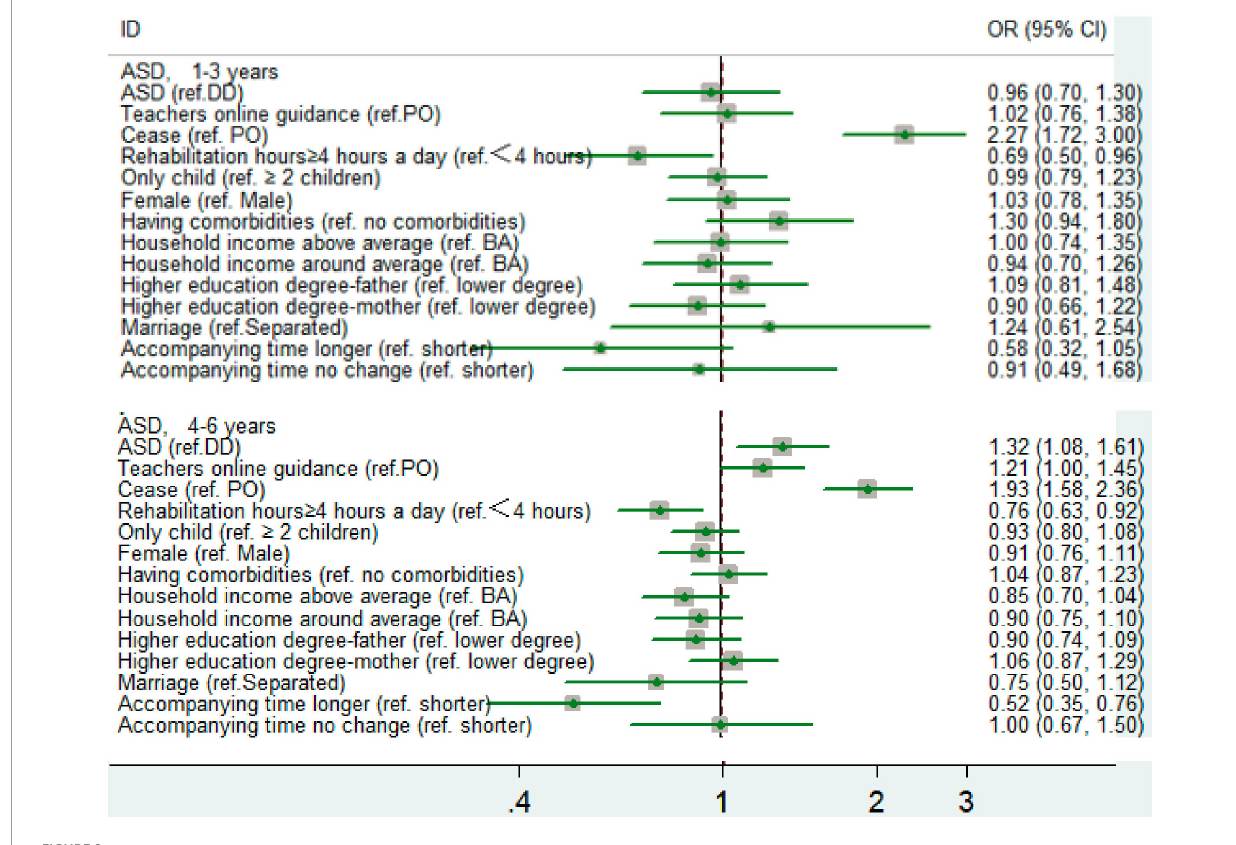
FIGURE2 The odds of negative emotional and behavioral change in two group.